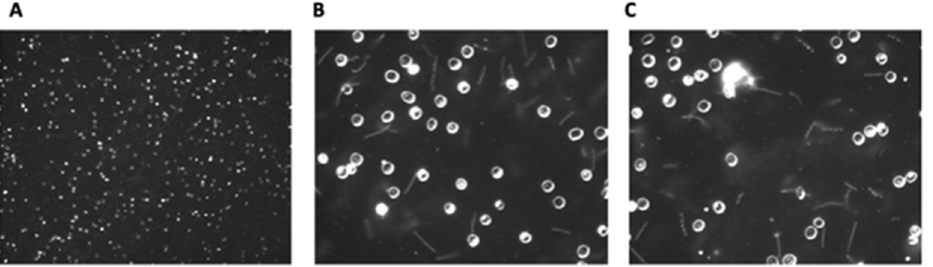
Figure 3. Dark field microscopic images of wet mount Borrelial spirochaetes ( Borrelia hermsii strain DAH). Blood from C3H-Hej mice infected with B. hermsii was diluted 4-fold with phosphate buffered saline. ( A ): 100×, ( B , C ): 400×.